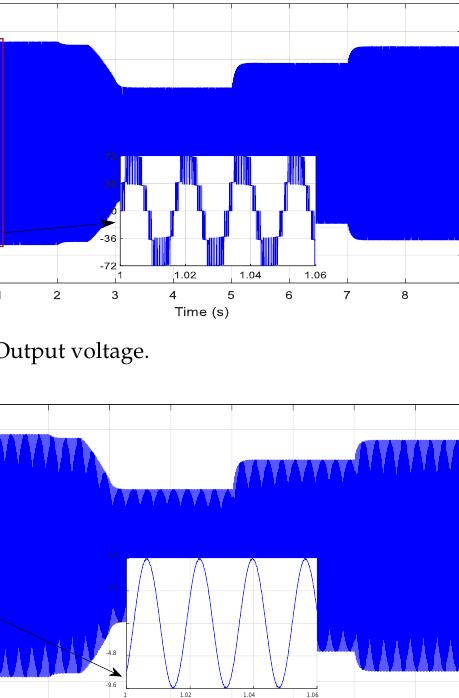
Figure 15. Output current.